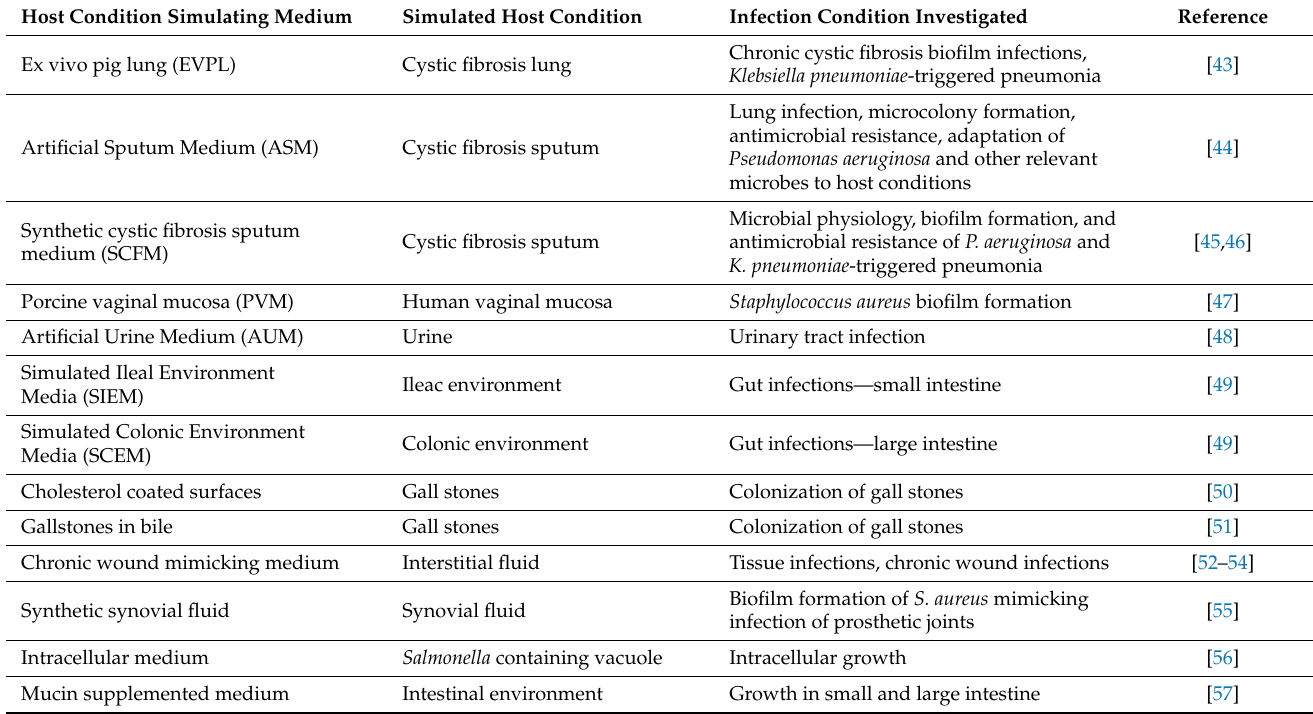
Table 1. Growth media closely simulating host